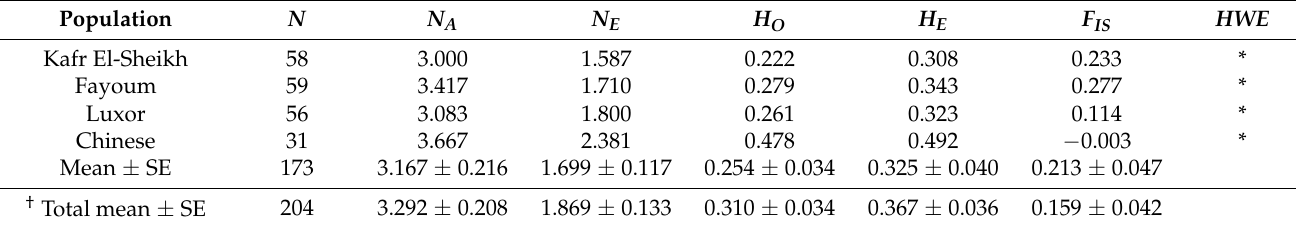
Table 5. Observed ( N A ) and effective ( N E ) number of alleles, observed ( H O ) and expected ( H E ) heterozygosity and fixation coefficient of an individual within a subpopulation ( F IS ) per